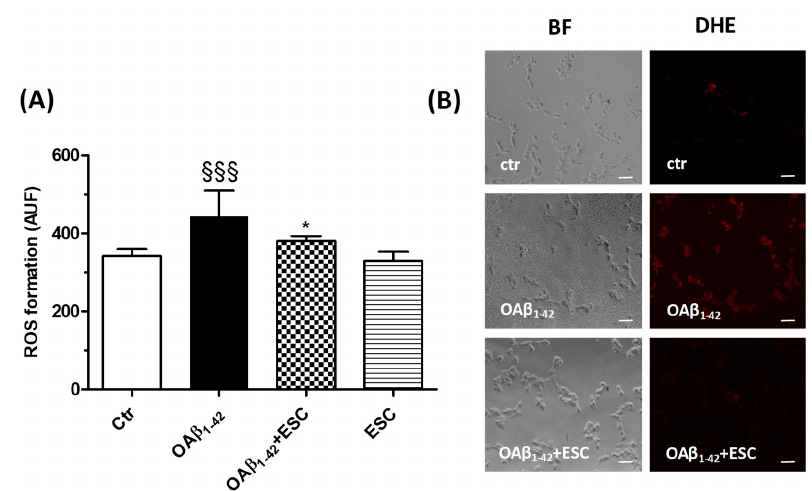
Figure 6. ESC prevents the ROS formation induced by OA β 1–42 in SH-SY5Y cells. ( A ) Cells were treated with ESC (20 µ M) for 24 h and then with OA β 1–42 (10 µ M) for 3 h. At the end of treatment, the ROS formation was determined using the fluorescent probe DHE. ( B ) Representative bright field (BF) and DHE fluorescence images. Data are expressed as AUF and reported as mean ± SD of three independent experiments ( §§§ p < 0.001 vs. untreated cells, * p < 0.05 vs. cells treated with OA β 1–42 at one-way ANOVA with Bonferroni post-hoc test). Scale bars: 100 μ M.